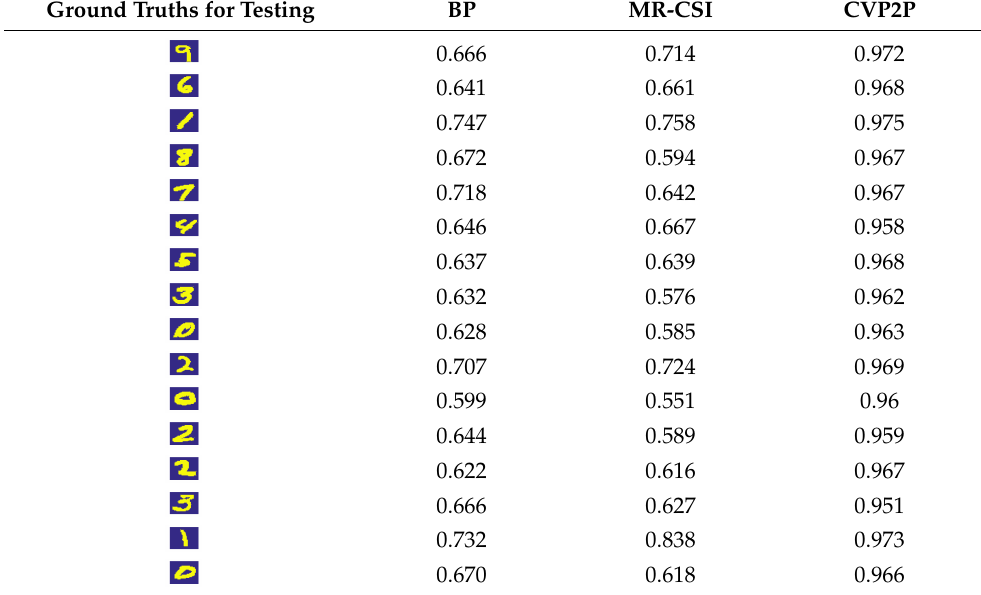
Table 2. CC results for the reconstructions in Figure